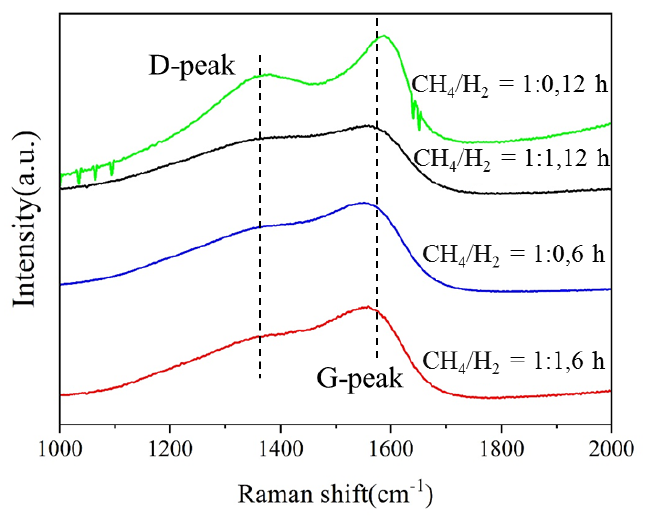
Figure 6. EPMA mapping and line scan of carbon element in the DLC coating cross-section depos- ited at ( a ) and ( b ) CH 4 /H 2 = 1:1, 6 h; ( c ) and ( d ) CH 4 /H 2 = 1:1, 12 h; ( e ) and ( f ) CH 4 /H 2 = 1:0, 6 h; ( g ) and ( h ) CH 4 /H 2 = 1:0, 12 h.